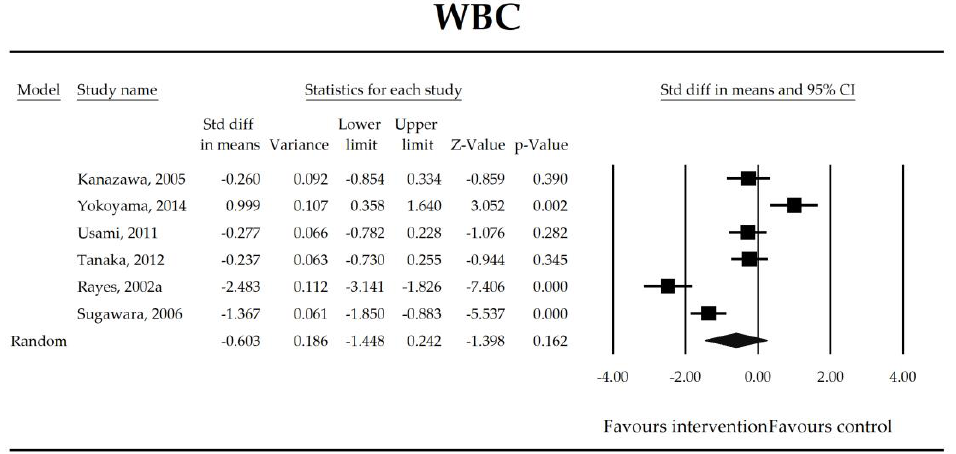
Figure 4. The effect size (standardized mean difference) for the concentration of WBC in patients taking probiotics (intervention) vs. No probiotics (control).